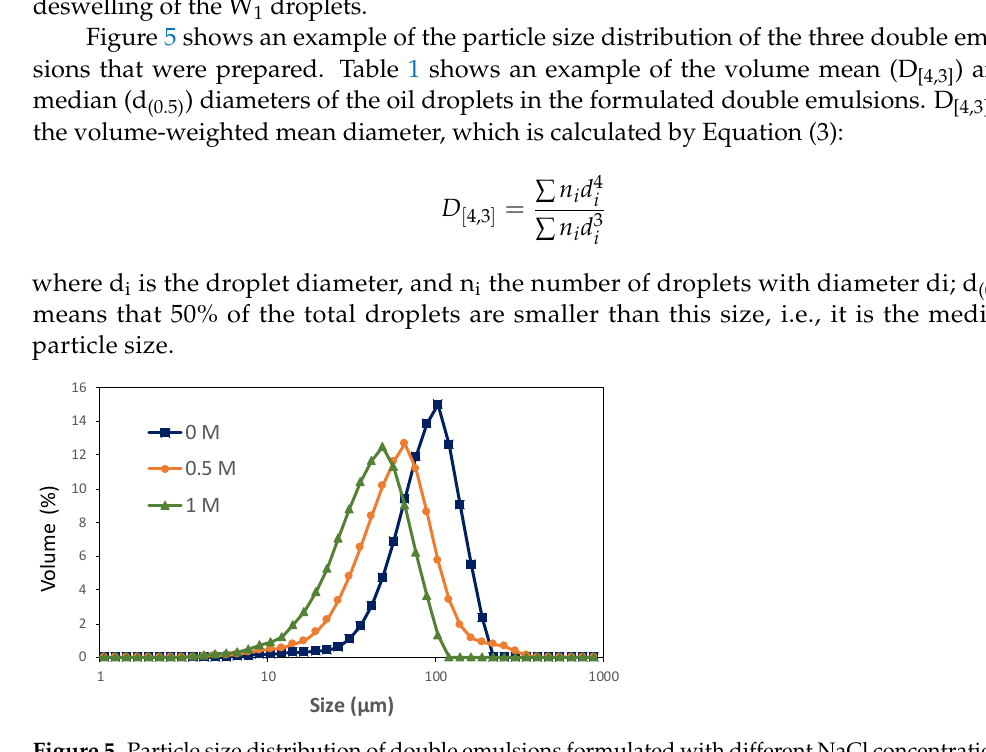
Figure 4. Centrifugation step to obtain continuous phase free of oil droplets.